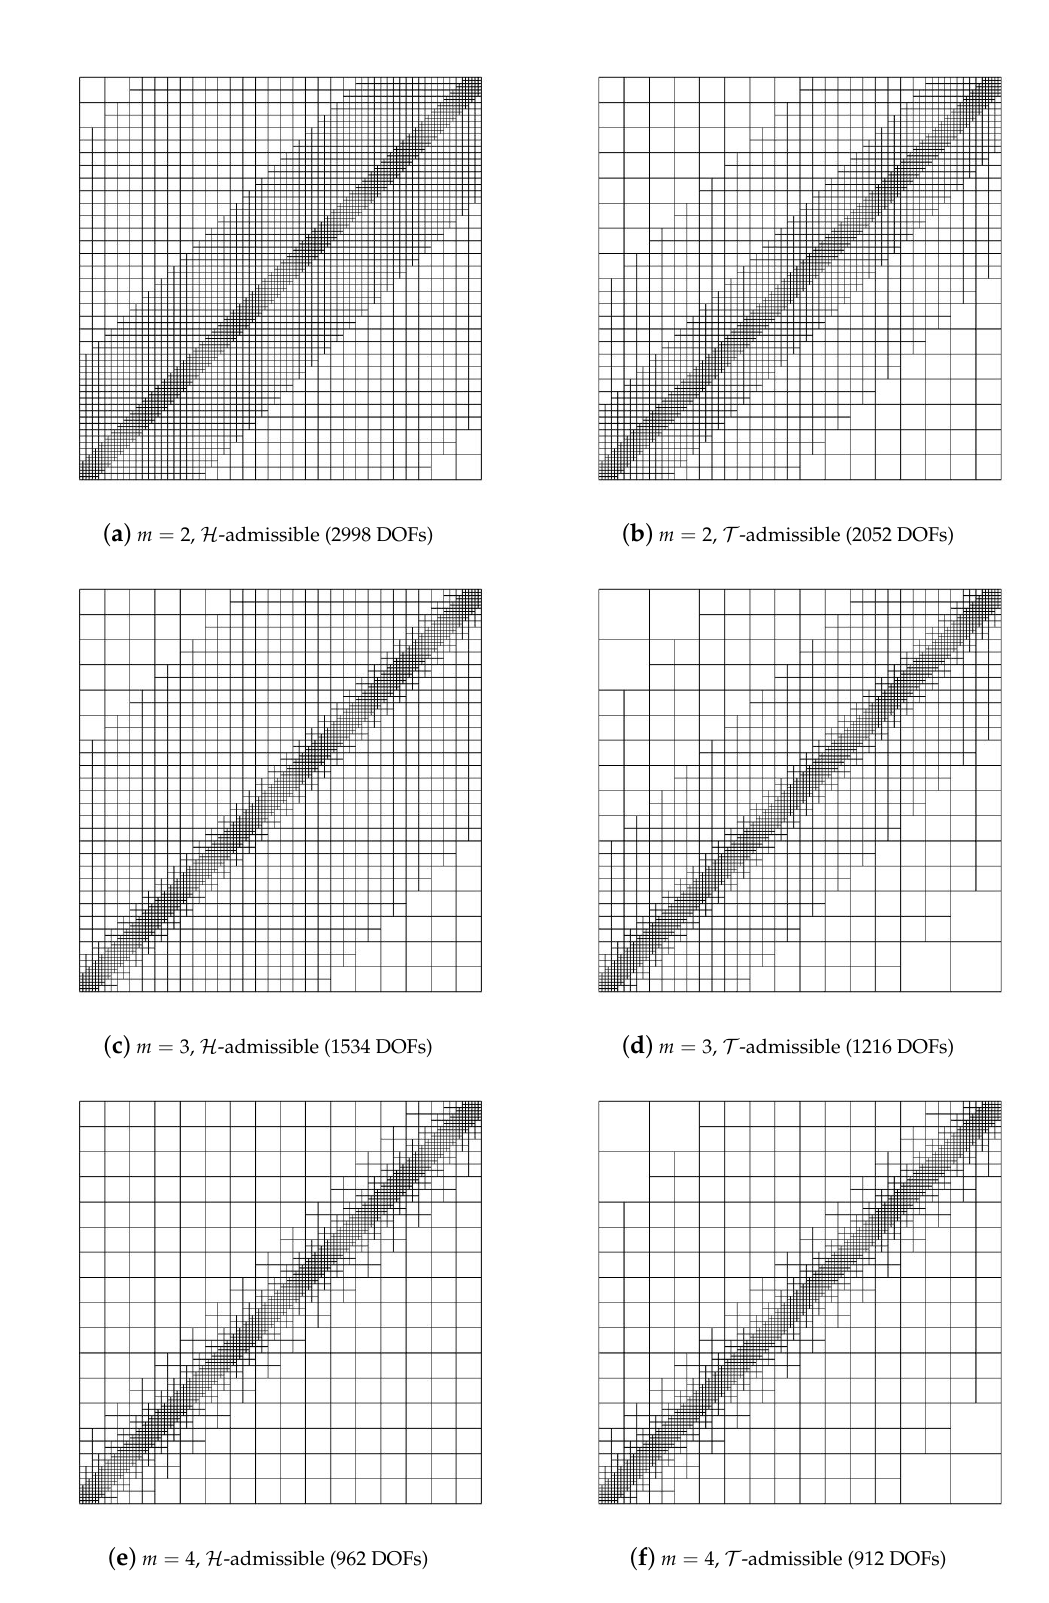
Figure 5. Hierarchical meshes obtained with p = ( 4,4 ) and m = 2,3,4 (from top to bottom ), by using H -admissible ( left ) and T -admissible ( right )